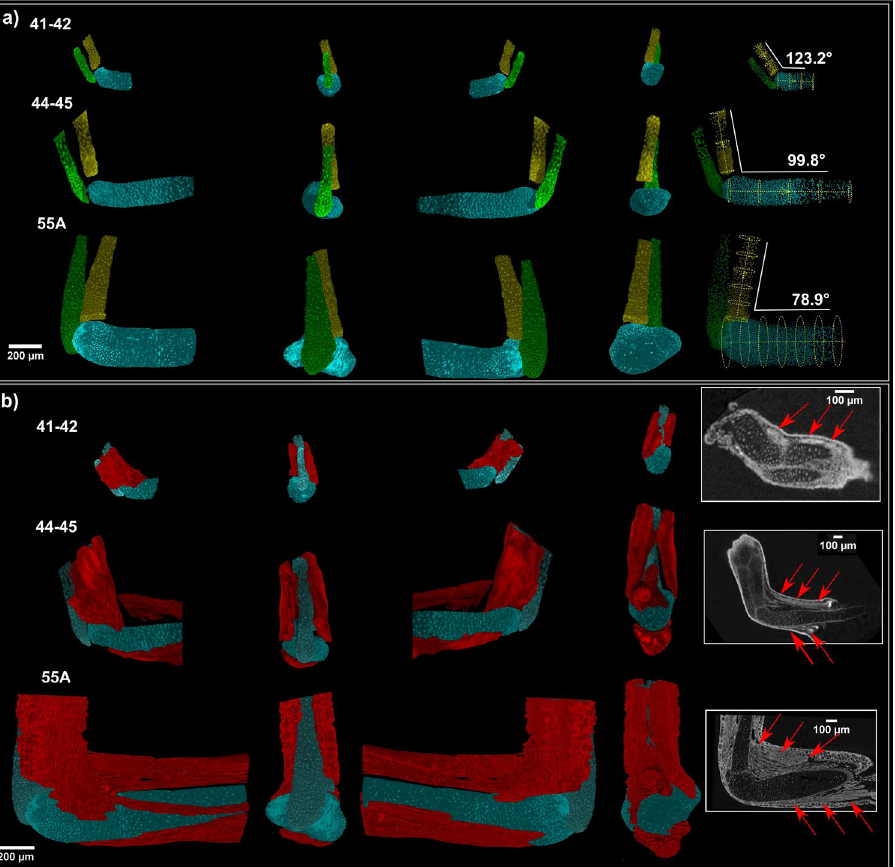
Figure 6. ( a ) Development of cartilage of the joint for three different developmental stages. The angle between ulna and humerus is decreasing with increasing developmental stage. ( b ) Visualization of joint simultaneously with developing muscles for three developmental stages. There is a correlation between decreasing angle and splitting of the